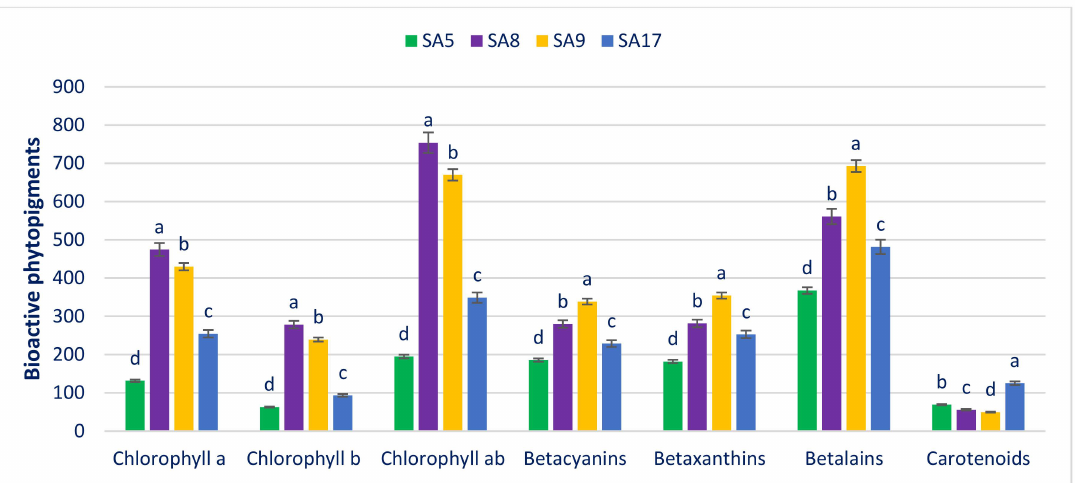
Figure 3. Bioactive pigments in danta leaves. Dissimilar letters over the bars indicate that the corresponding data significantly differed by DMRT ( p < 0.01, n =